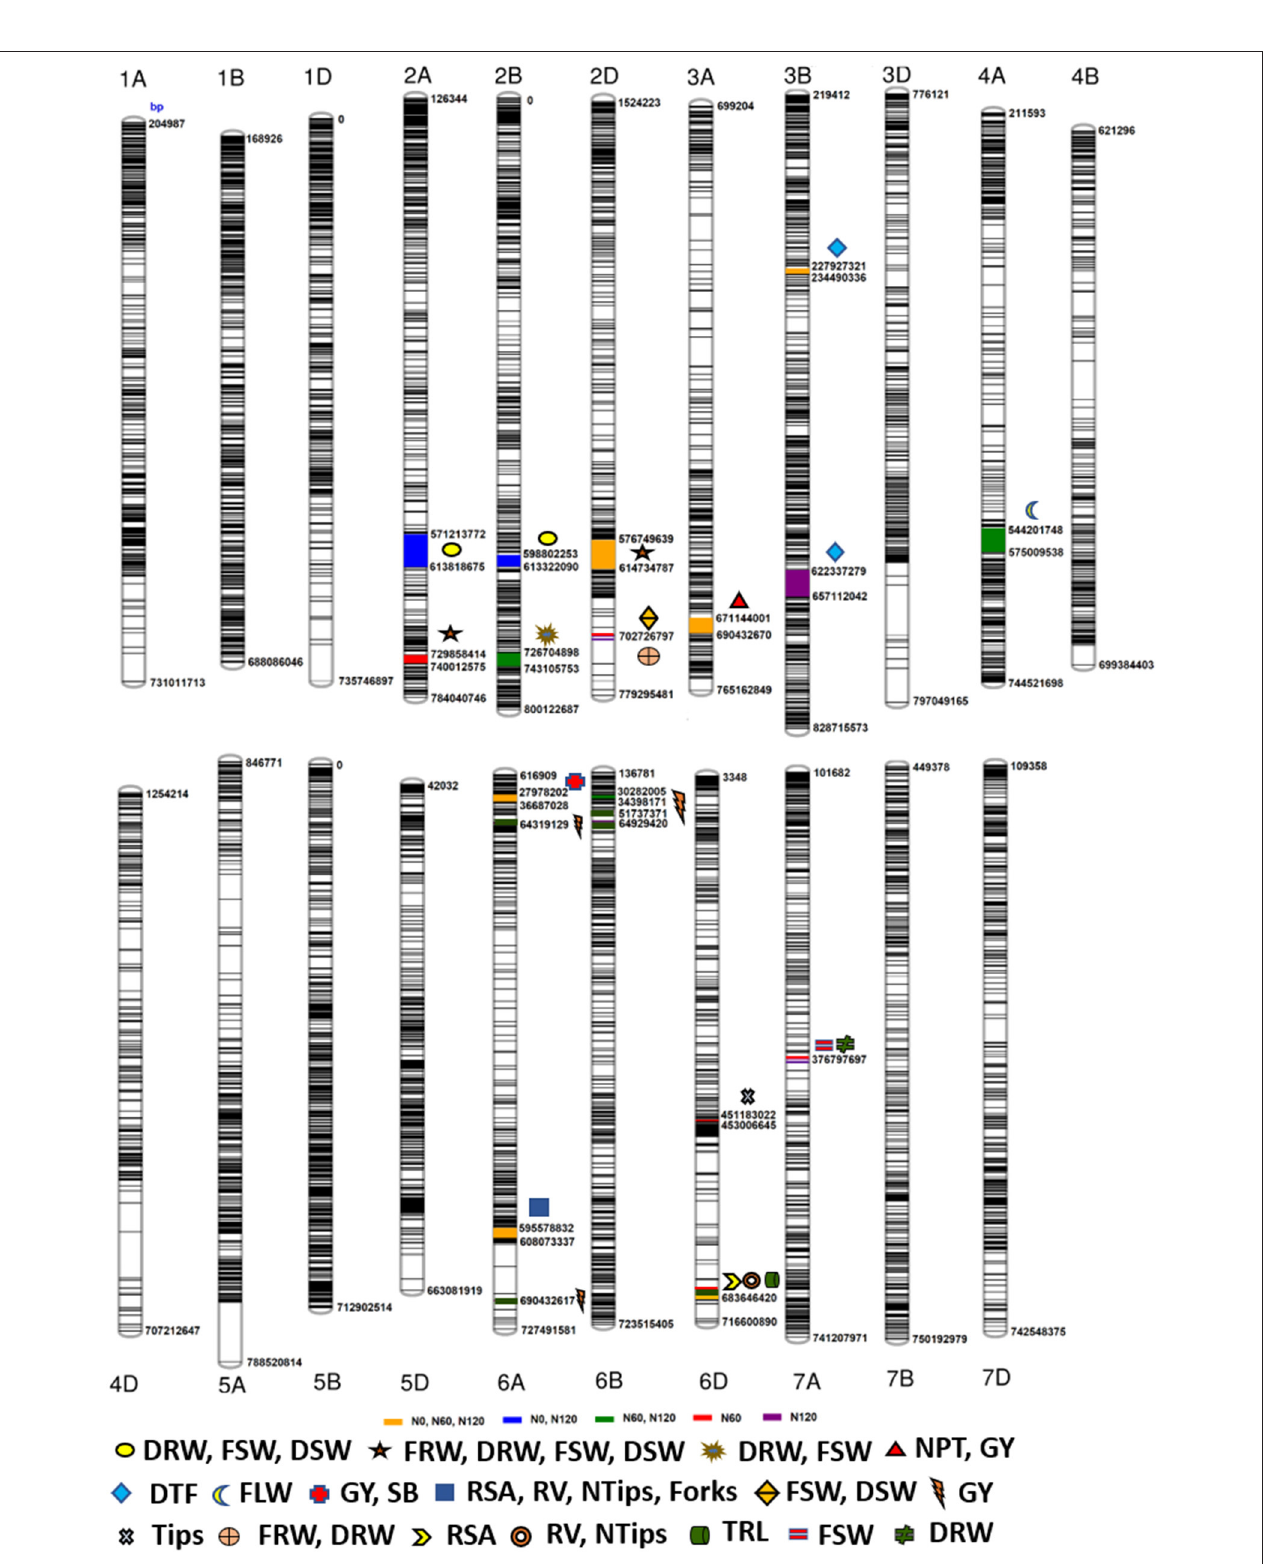
FIGURE 5 | Schematic representation of the single nucleotide polymorphism (SNP) distribution along the 21 chromosomes of wheat. The chromosome map showing genomic regions where marker-trait associations (MTAs) for different nitrogen-use efficiency (NUE)-related trait, root traits, yield, and yield-related traits. The numbers below each chromosome indicate chromosome numbers. The bp represents the physical position of the SNPs on the chromosome in base pair.